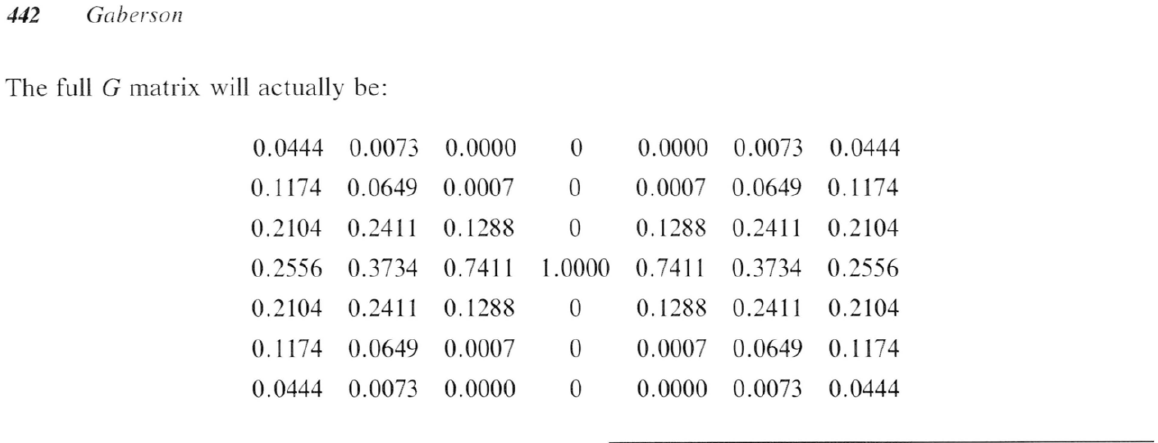
FIGURE 5 Choi- Williams distribution for Twosines with (J' = I.